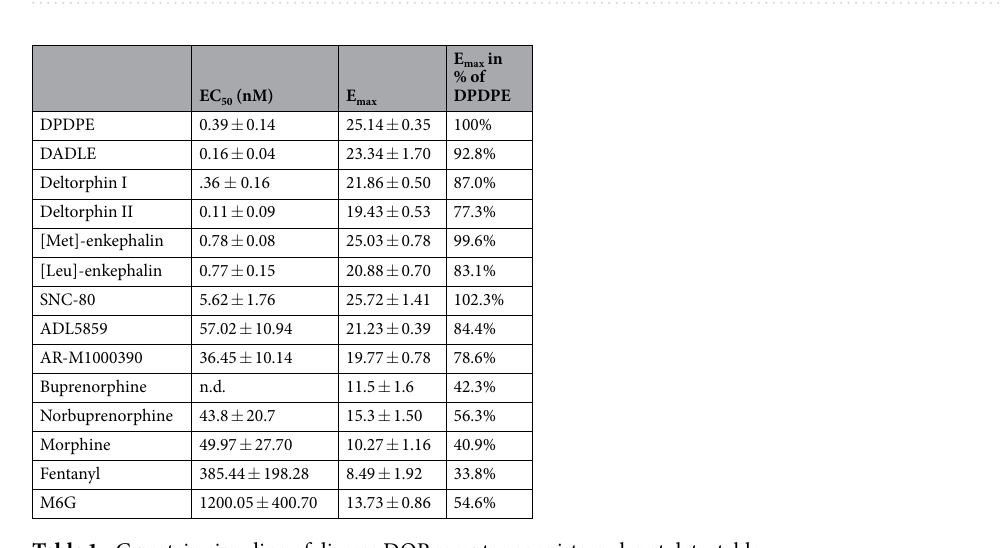
Figure 5. G protein signaling of diverse DOP receptor agonists. AtT-20 cells stably expressing HA-hDOP receptors were stimulated with vehicle, or DPDPE, deltorphin I (A) , SNC80 (B) , ADL5859 (C) , AR-M1000390 (D) , fentanyl (E) or morphine (F) at a concentration range of 10 − 6 to 10 − 13 M and GIRK channel activation was measured in a membrane potential assay. Dose response curves were calculated with OriginPro using sigmoidal non-linear fitting for data from three independent experiments performed in duplicate (mean ± SEM). Vehicle- induced changes in fluorescence signal (background) were subtracted from signals obtained using agonist- containing solutions. The DPDPE graph is the same in every panel and serve as a comparator. RFU, relative fluorescence units.